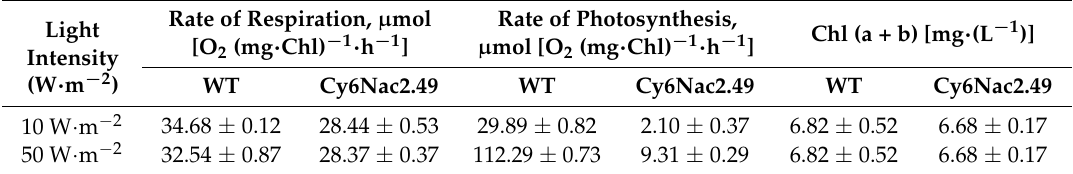
Table 1. Changes in the rate of respiration and rate of photosynthesis in wild-type and cy6Nac2.49 strain of C. reinhardtii at different light